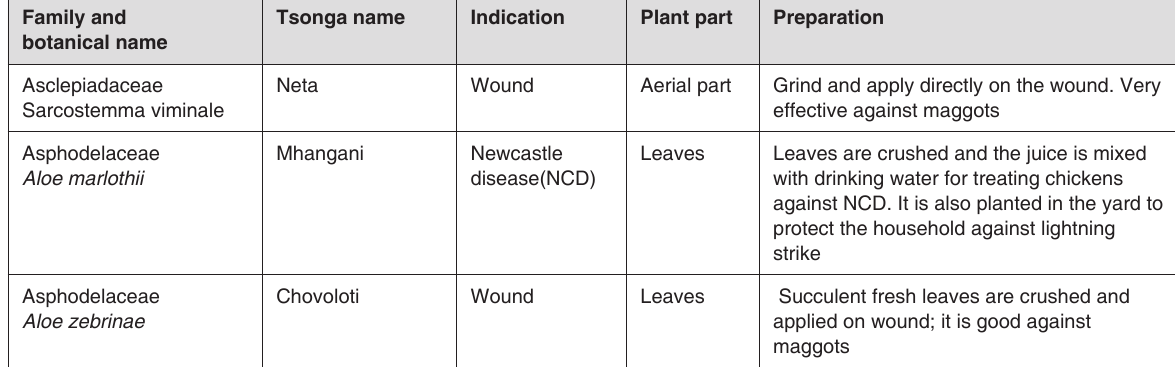
TABLE 2 List of plant family and botanical names followed by Tsonga names, plant part (s) used, indication(s), preparation and dos- age where applicable Family and botanical